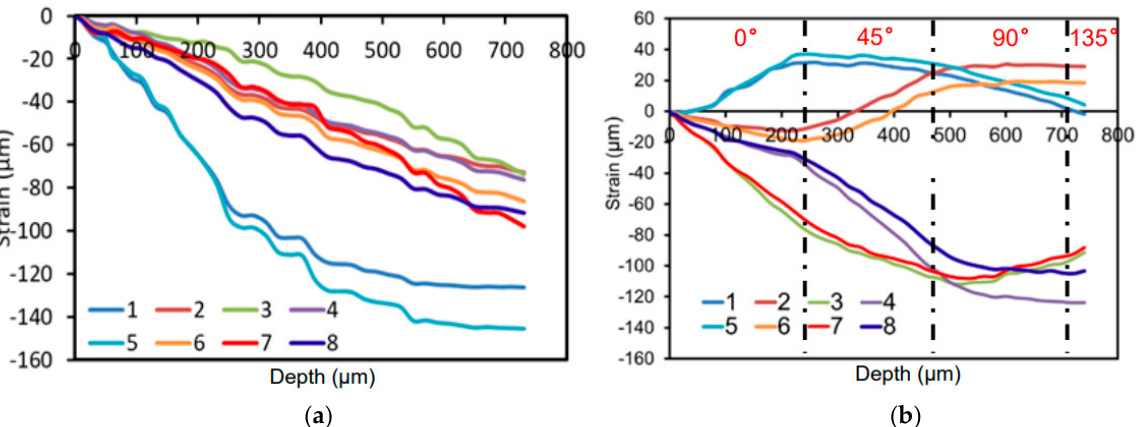
Figure 9. Measured surface strains in 8 directions as a function of drilling depth for ( a ) the unidirec- tional and (b) multidirectional ( b ) CFRP.